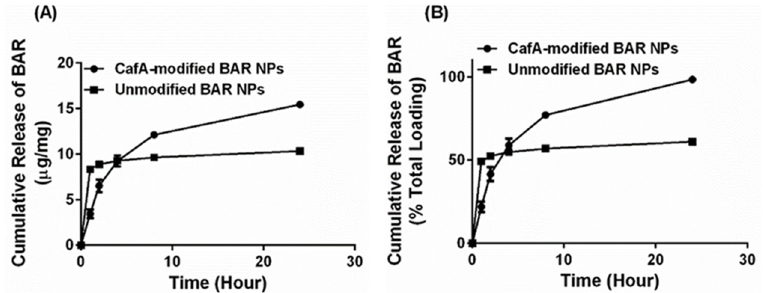
Figure 4. Cumulative release of BAR as a function of ( A ) mass (µg BAR per mg NP) and ( B ) percent of total BAR encapsulated. Error bars represent the mean BAR released ± standard deviation. Please note that in some cases the error bars are smaller than the data point